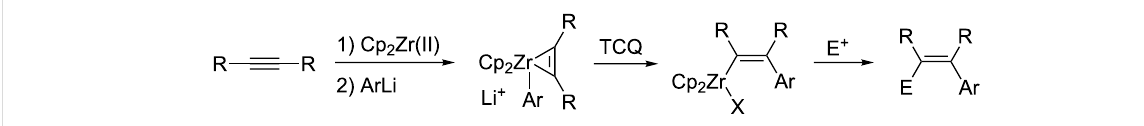
Scheme 2: Carbozirconation of alkynes via zirconacyclopentenes.